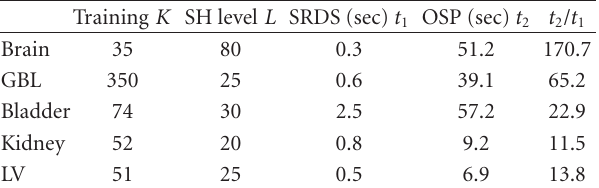
Table 10: Computational time of SRDS and